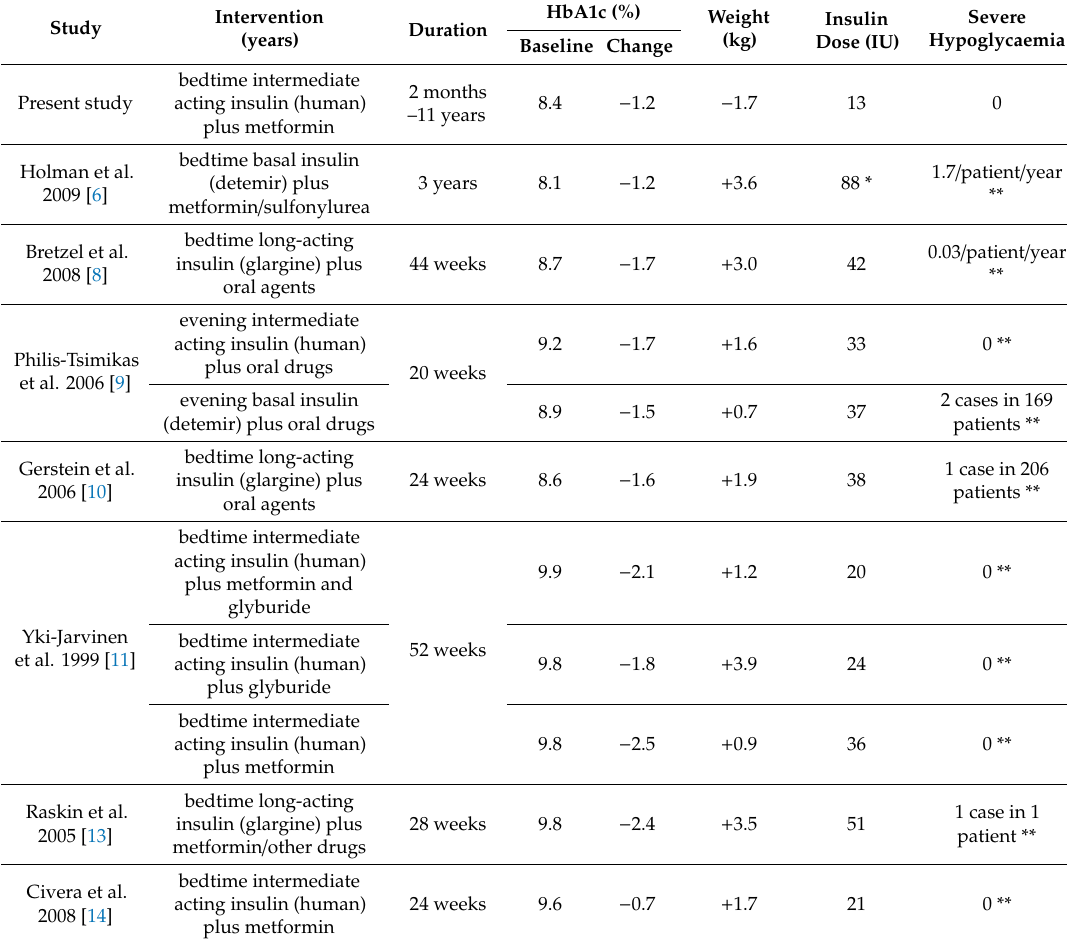
Table 3. Comparison of studies with basal supported oral